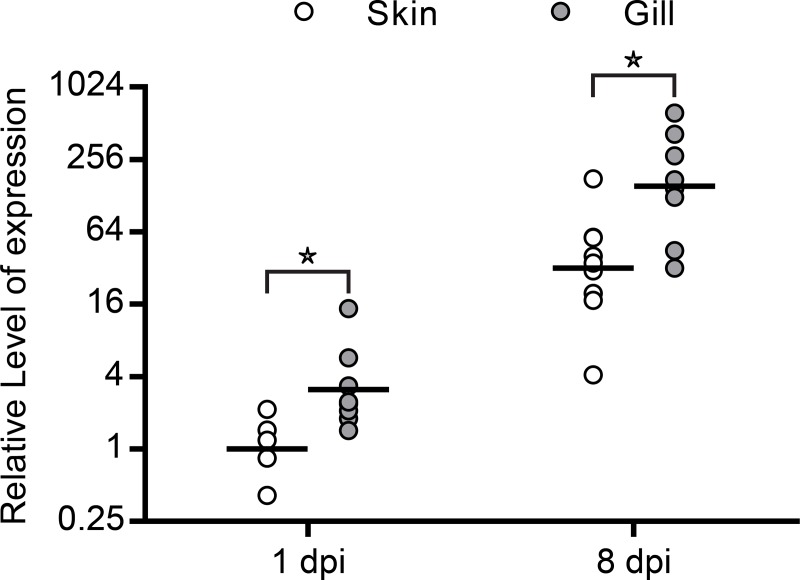
Relative levels of I. multifiliis is represented relative to the reference gene EF1α by calculating 2-ΔCq normalized to the group having the lowest expression level, skin at 1 dpi.Student t-test (p<0.05) showed that gills had significantly higher level of I. multifiliis at both 1 dpi and 8 dpi (3.1 and 4.8 fold, respectively). No transcription of the gene was recorded in spleen.